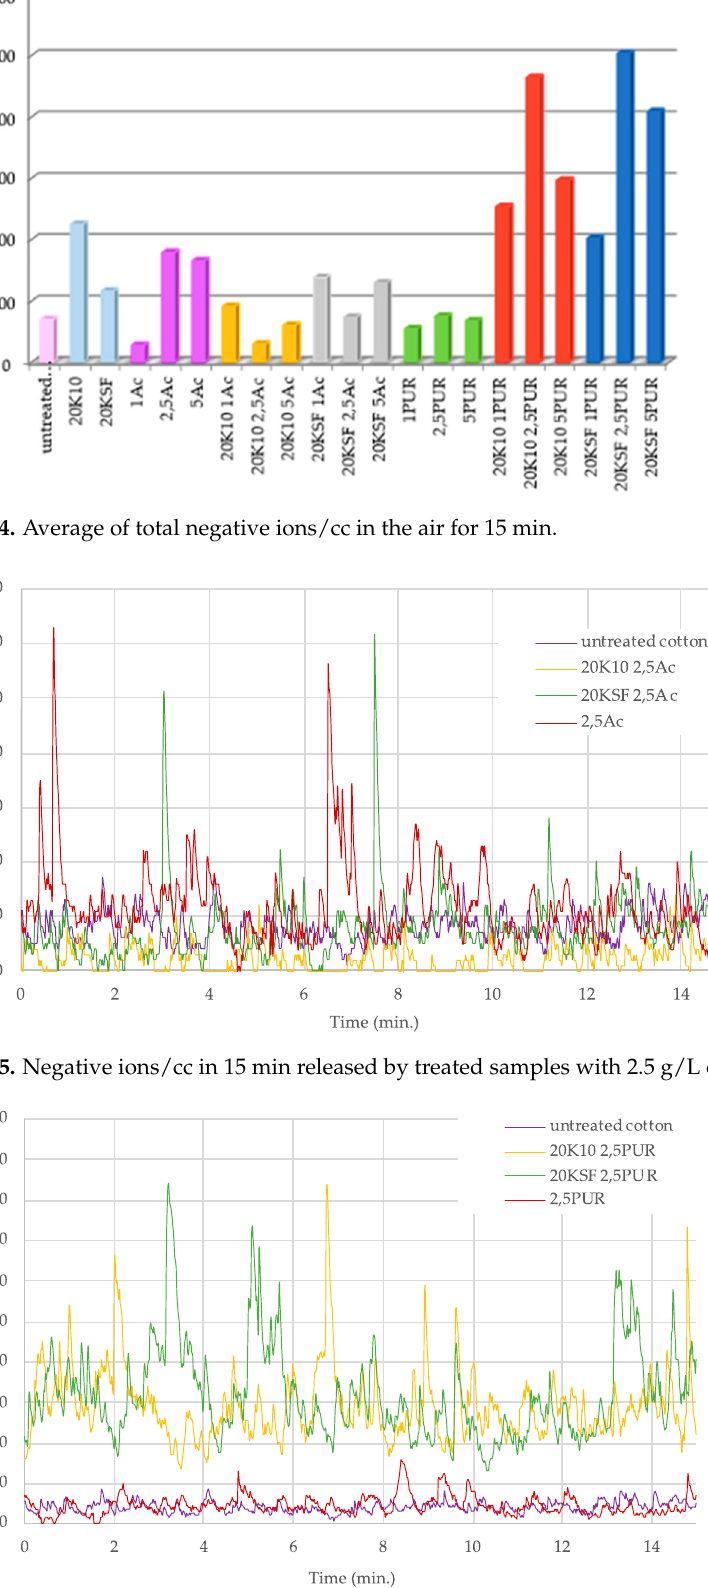
Figure 6. Negative ions/cc in 15 min released by treated samples with 2.5 g/L of polyurethane binder.